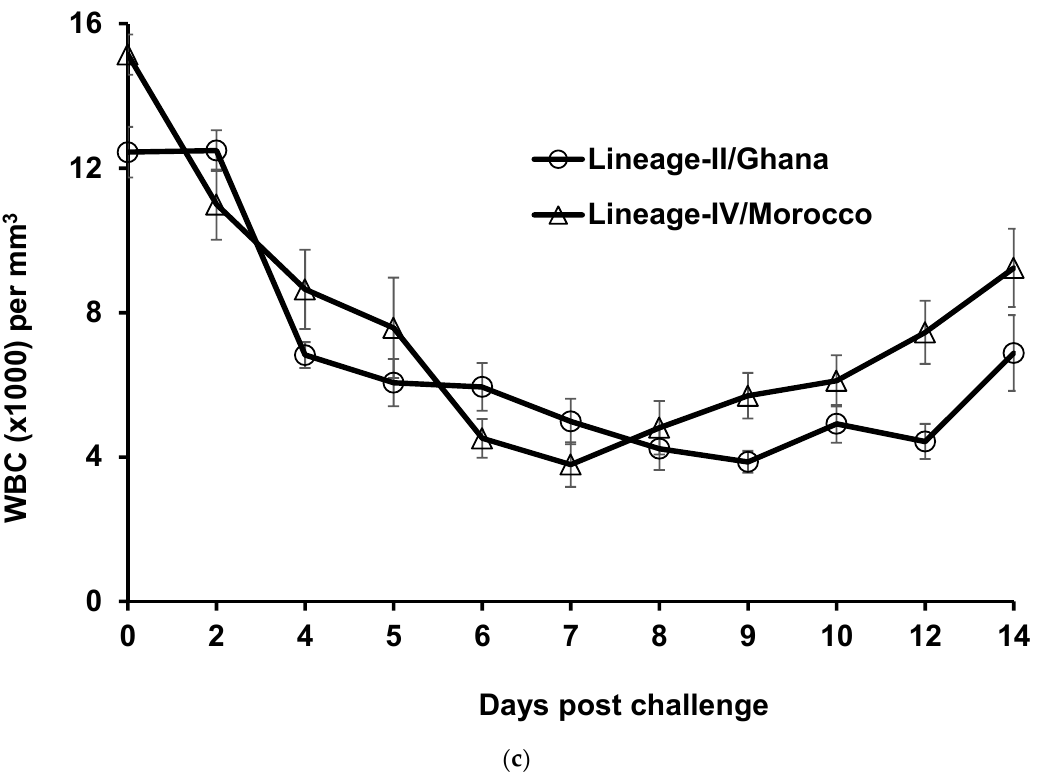
Figure 1. ( a ) Rectal body temperature of goats post-challenge; ( b ) Mean clinical score of Peste des petits ruminants virus (PPRV)-challenged goats; ( c ) Mean leucocyte count in blood of PPRV-challenged goats.